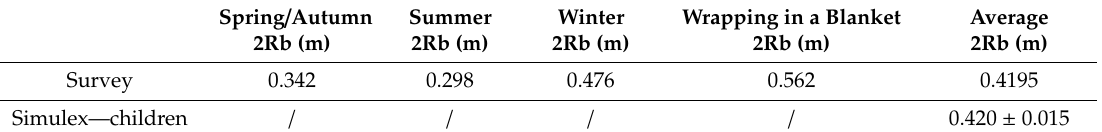
Table 3. Parameter settings for personnel.